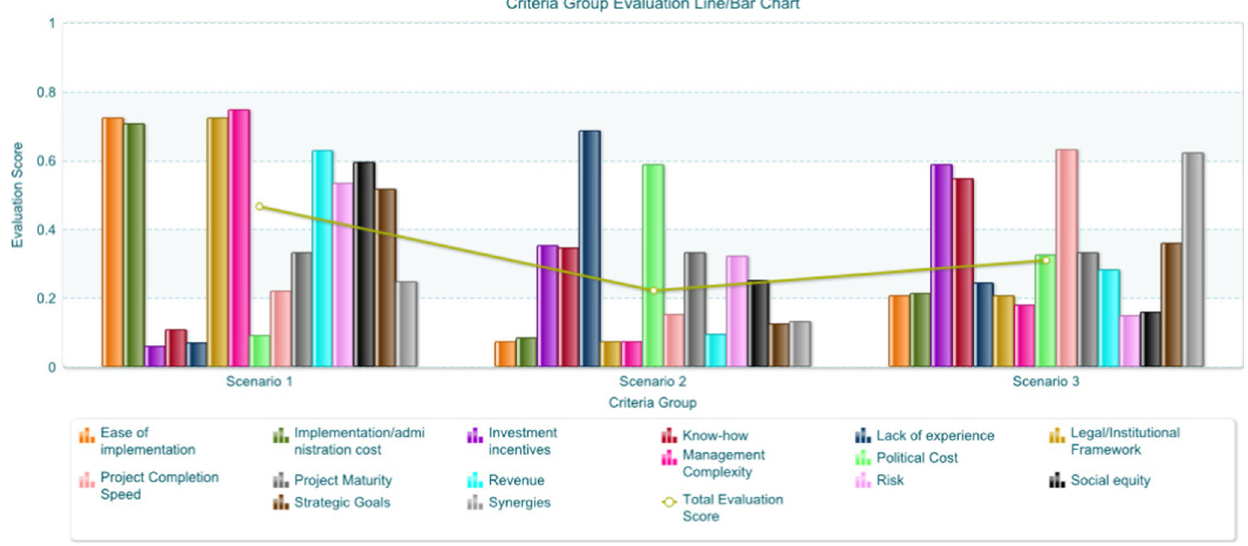
Fig. 6 Criteria Group A Evaluation Line/Bar Chart (MAMCA Software, own